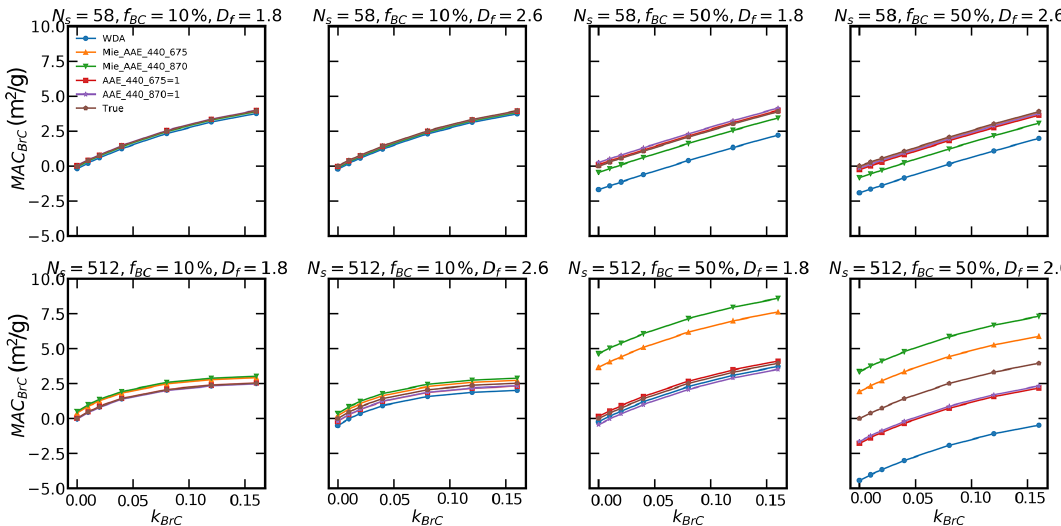
Figure 4. Comparison of the true and inferred BrC MAC ( λ = 440nm).